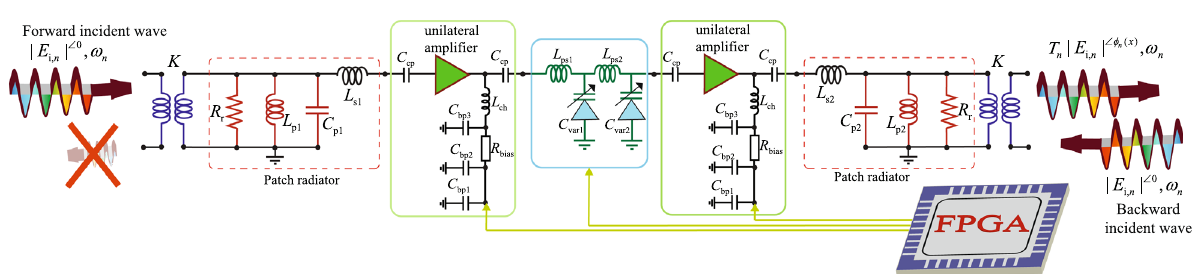
Figure 4. A circuit model for the five-stage frequency-dependent spatially-varying radiating super-cell in Fig.